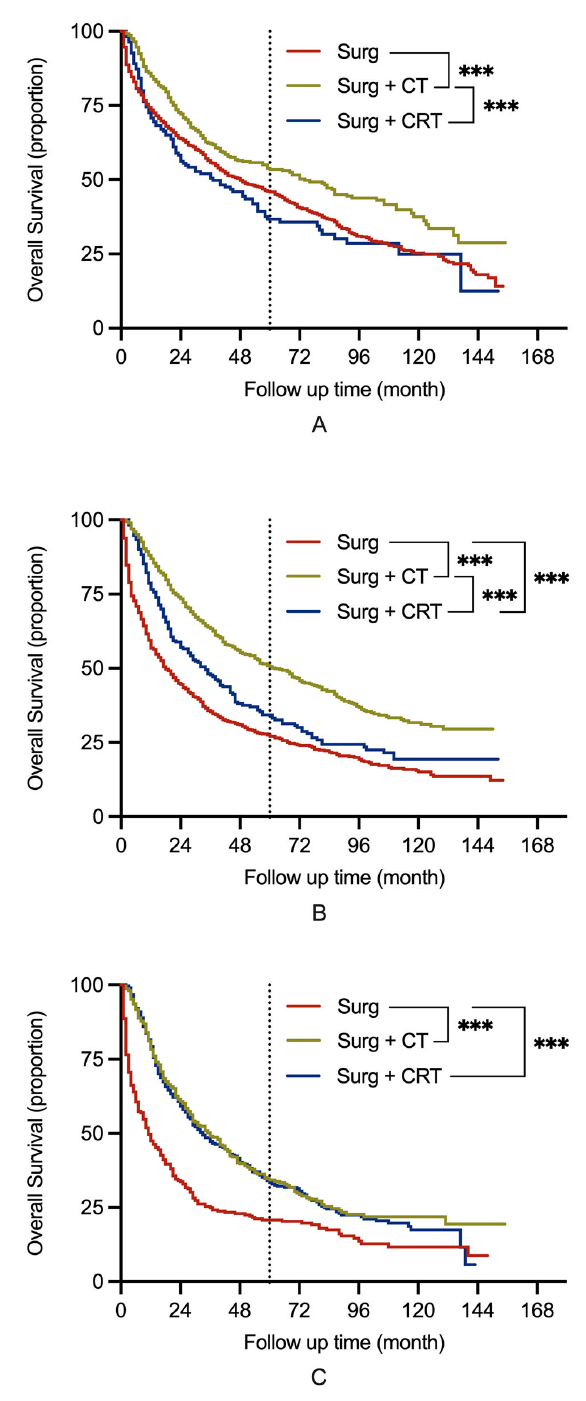
Figure 1. Overall survival in NSCLC patients with N0 ‐ 2 stage undergoing pneumonectomy. ( A ) N0 stage; ( B ) N1 stage; ( C ) N2 stage. Note: Surg, surgery; CT, chemotherapy; CRT, chemoradiotherapy; NSCLC, non ‐ small cell lung cancer; vs., versus; *** Indicates significant difference at p < 0.001. In the N1 and N2 groups, patients who received CT and CRT had a better prognosis than those who only received surgical therapy ( p < 0.001) (Figure 1B, C). In particular, the OS in patients who underwent surgery with CT was significantly better than that in patients who underwent surgery with CRT in the N1 group ( p < 0.001) (Figure 1B), while the OS was comparable in the respective subgroup analysis in the N2 group ( p = 0.614) (Figure